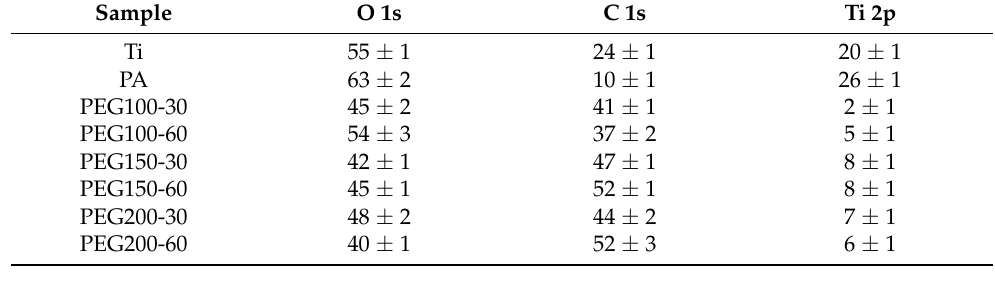
Table 4. Atomic concentration (in %) of the carbon, oxygen and titanium amount present on the Ti, and PA.